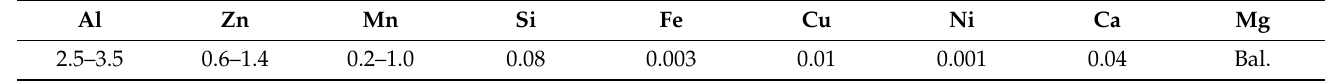
Table 1. Chemical compositions of the AZ31B base metal and filler wire (wt. %).